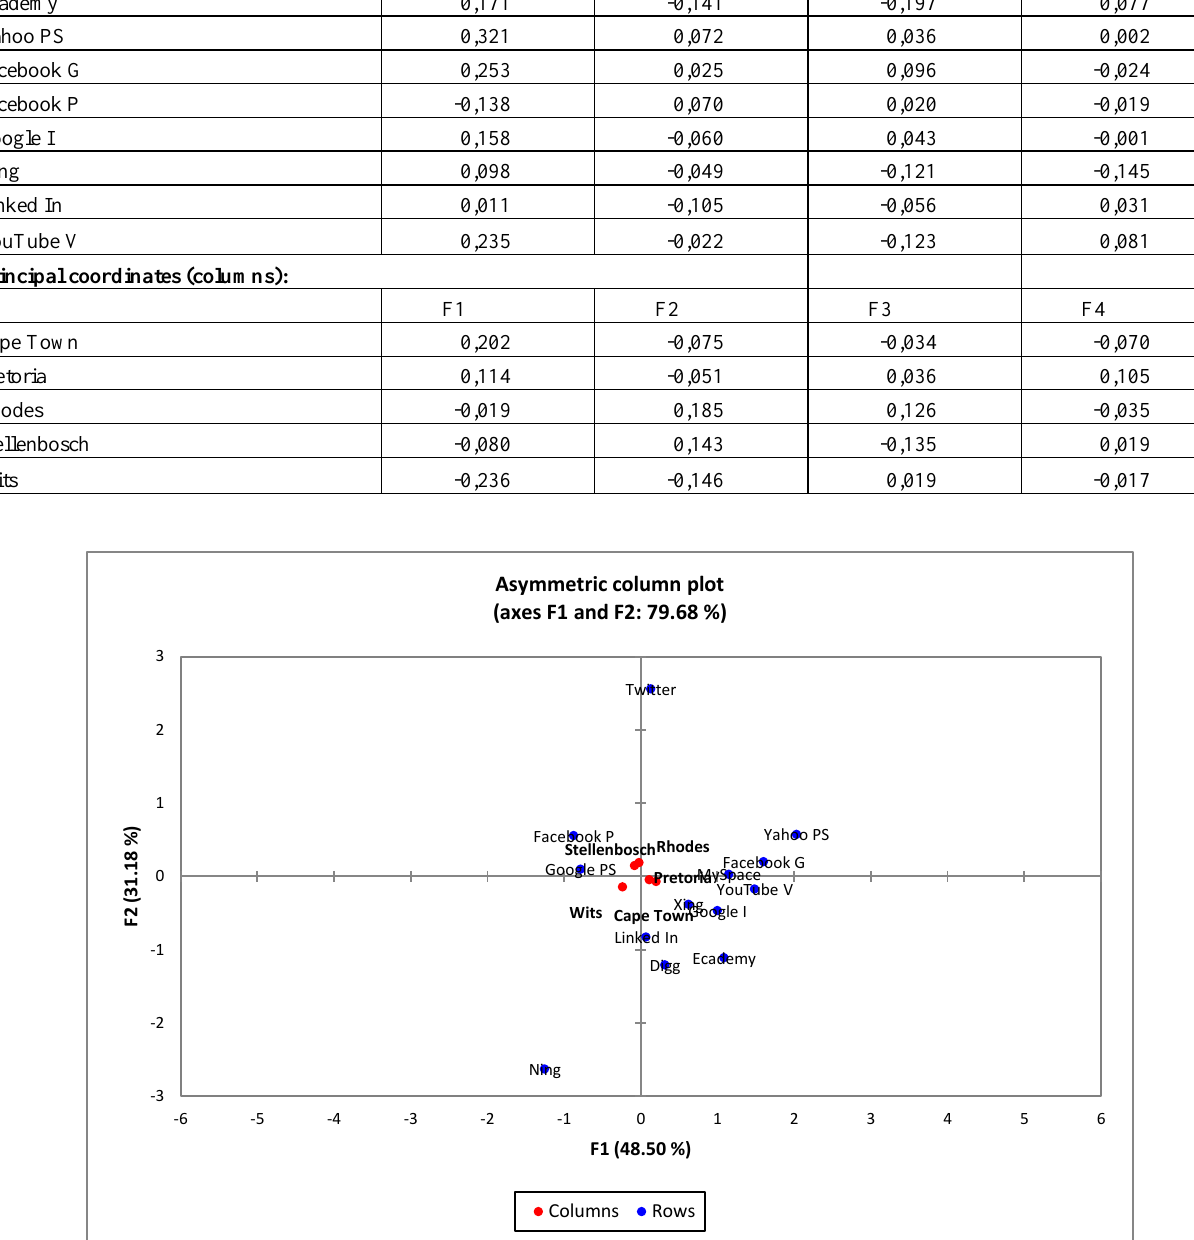
Figure 3. Asymmetric column plot (axes F1 and F2: 79,67